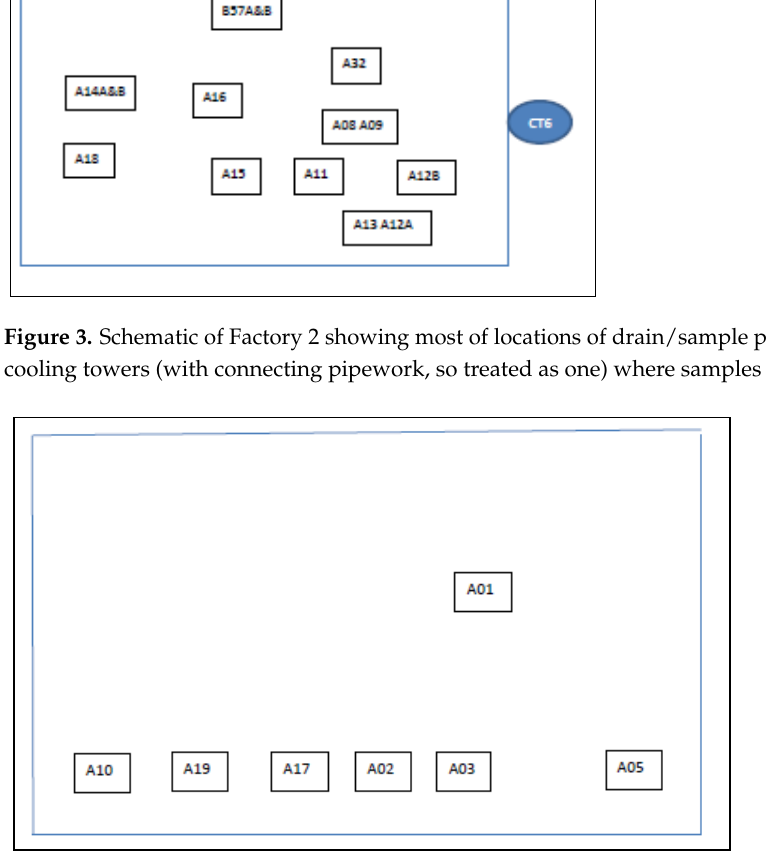
Figure 4. Schematic of Factory 5 showing locations of drain/sample points fed by CT3/6 from Fac- tory 2.